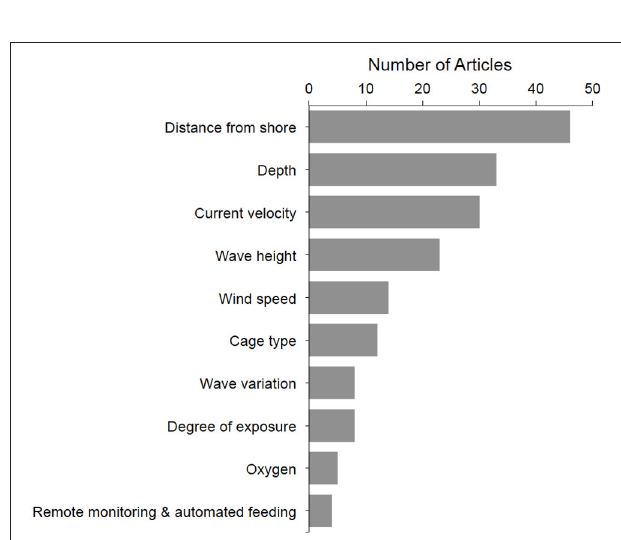
FIGURE 3 | Top 10 most referenced criteria for “offshore aquaculture” and the number of articles that reference each metric. A paper can fall into one or more of these classifications.